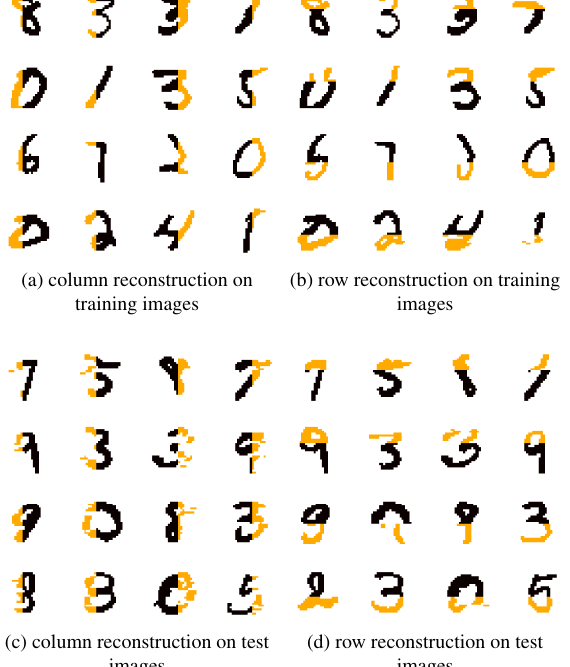
FIG. 6. Image reconstruction from partial images by direct sampling with the same MPS as in Fig. 4. (a,b) Restoration of images in Fig. 5(b), which are selected from the training set. (c,d) Reconstruction of 16 images chosen from the test set. The test set contains images from the MNIST database that were not used for training. The given parts are in black (dark) and the reconstructed parts are in yellow (light). The reconstructed parts are 12 columns from either (a,c) the left or the right and (b,d) the top or the